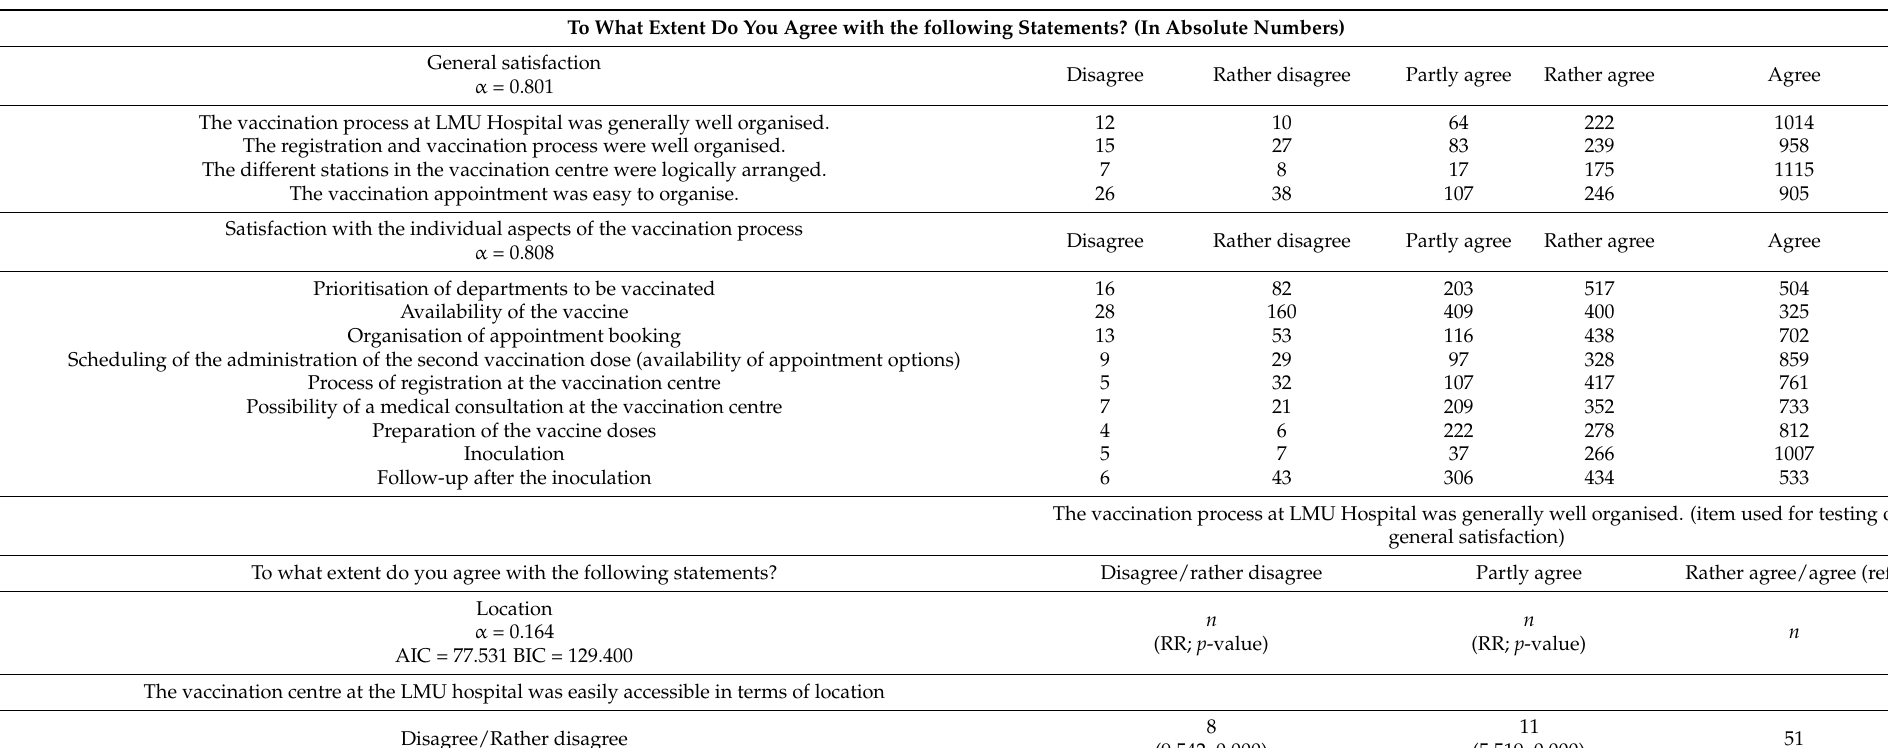
Table 2. Frequency distribution of the satisfaction of LMU Hospital’s employees with the vaccination centre and contextual influences and geographic barriers affecting the overall satisfaction with the vaccination centre tested with multinomial logistic regression (unadjusted model presented, ◦ ). To What Extent Do You Agree with the following Statements? (In Absolute